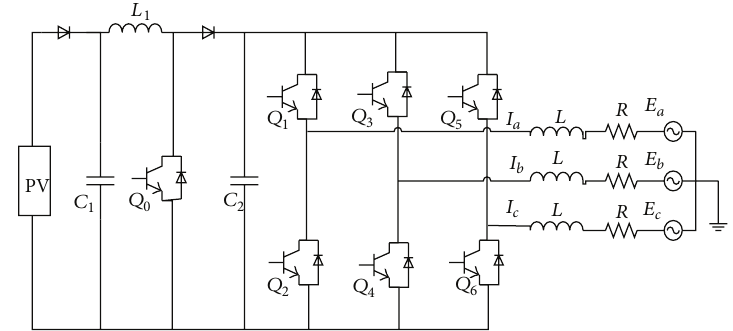
Figure 3: Structure diagram of three-phase photovoltaic grid-connected inverter.